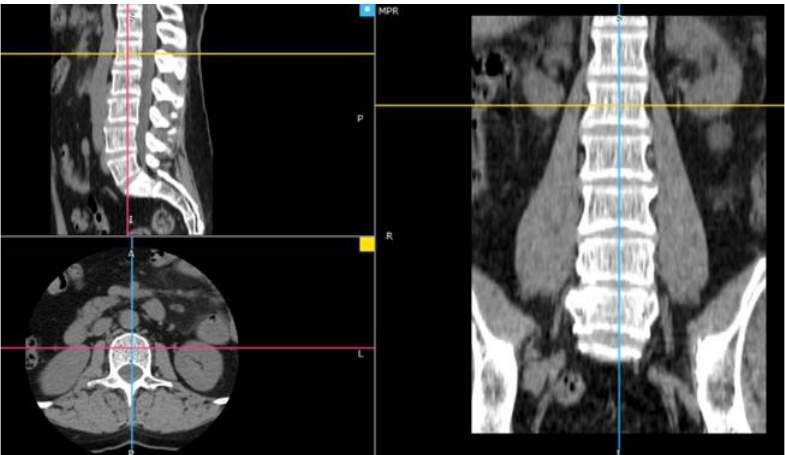
Figure 1. The arrangement of the axis in the centre of one of the vertebrae (image in three projec- tions).